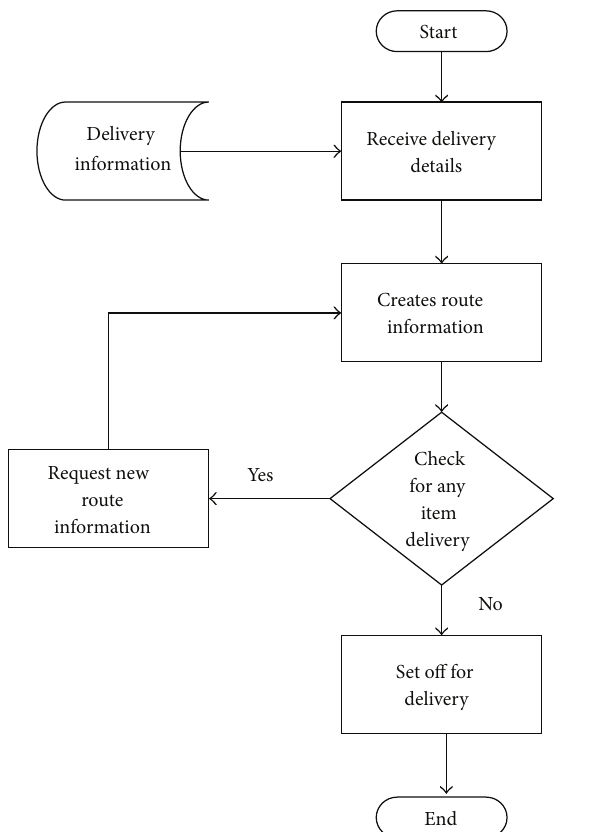
Figure 7: Basic scenario logic for delivery route information.